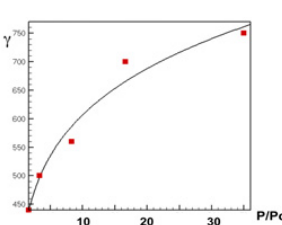
Figure 2. The maximum electron Lorentz factor (cid:7) obtained in the test-particle calculations carried out with the parameters (cid:1) 0 = 1 (cid:2) m, initial FWHM w 0 = 7 (cid:2) m, as a function of the parameter P/P c